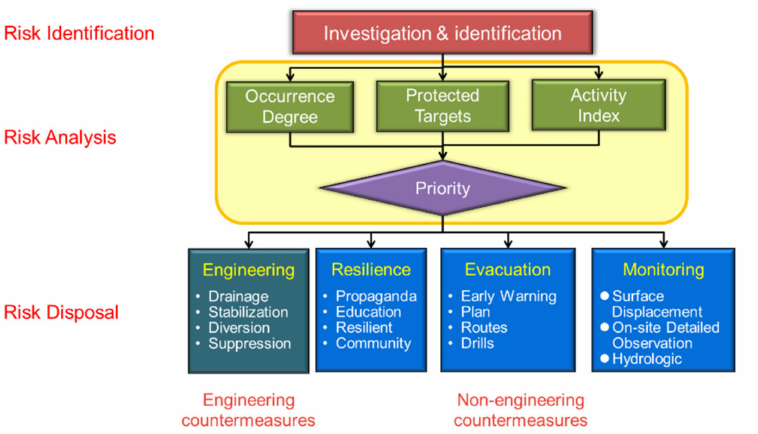
Figure 2. Strategy of large-scale landslide hazard mitigation in Taiwan. (modified from the Soil and Water Conservation Bureau,